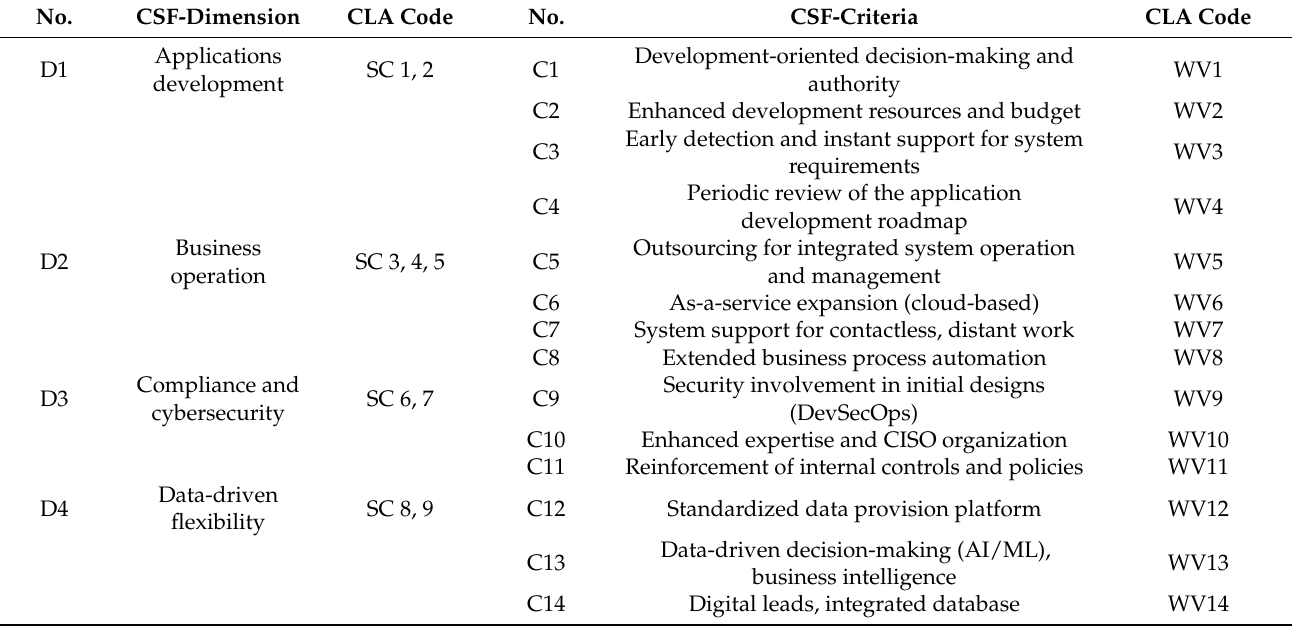
Table 5. CSFs derived from key issues of CLA (dimensions and